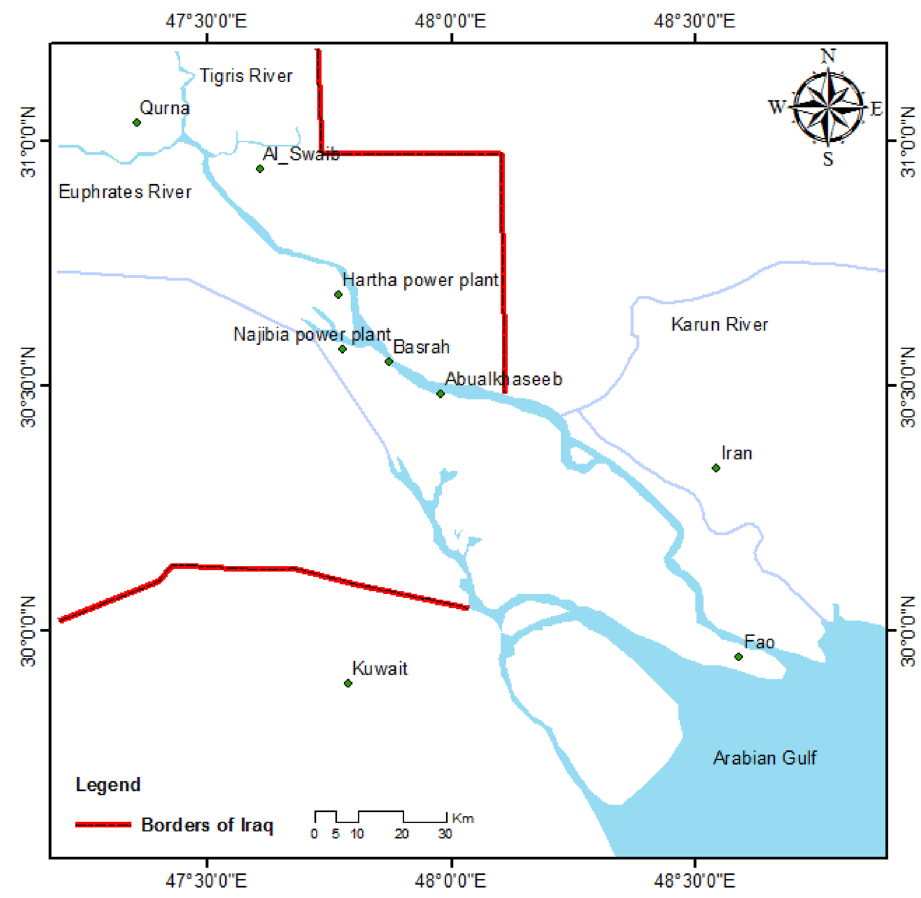
Fig. 1 Map of study area and location of Hartha and Najibia power